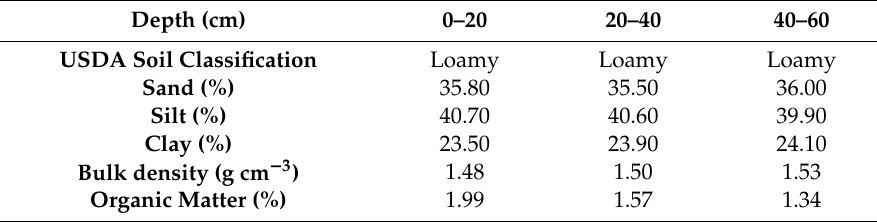
Table 1. Physical soil properties at the IRTA orchard in Mollerussa, at three depths. Depth